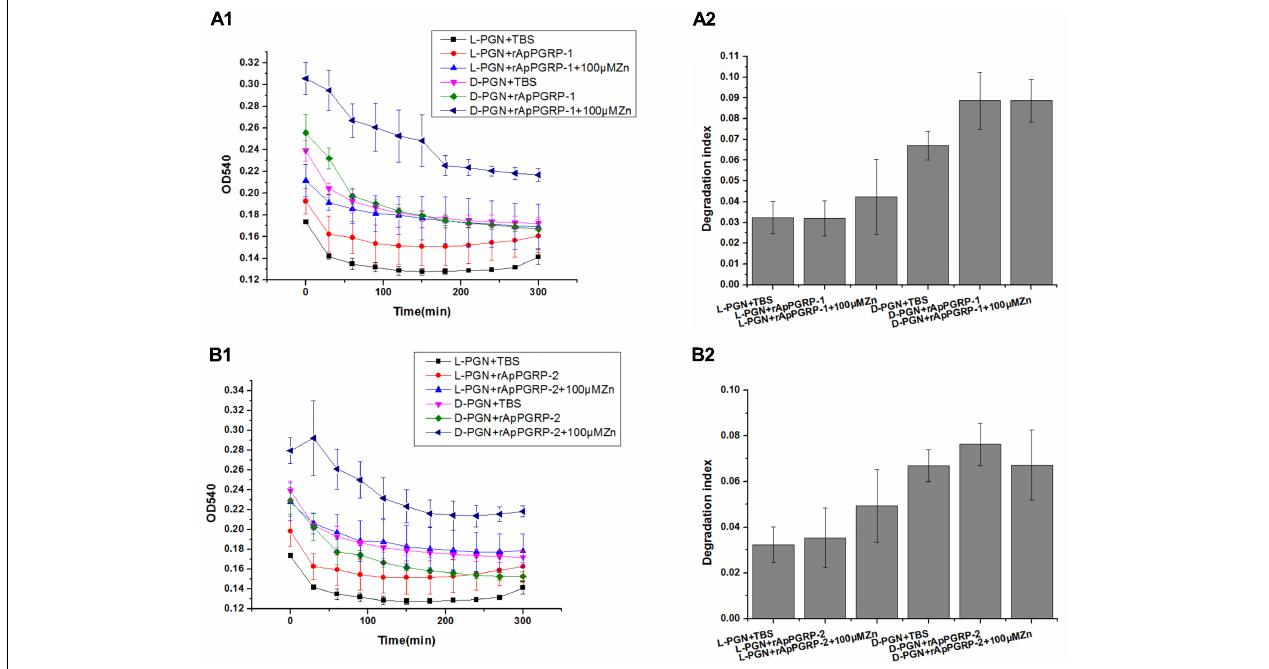
FIGURE 8 | Activity of rApPGRP-1 and -2 in the degradation of L-PGN and D-PGN. (A1 , A2) , OD 540 change and degradation index of rApPGRP-1, respectively; (B1 , B2) , OD 540 change and degradation index of rApPGRP-2, respectively. Degradation index = OD 540 (0 min)–OD 540 (300 min).